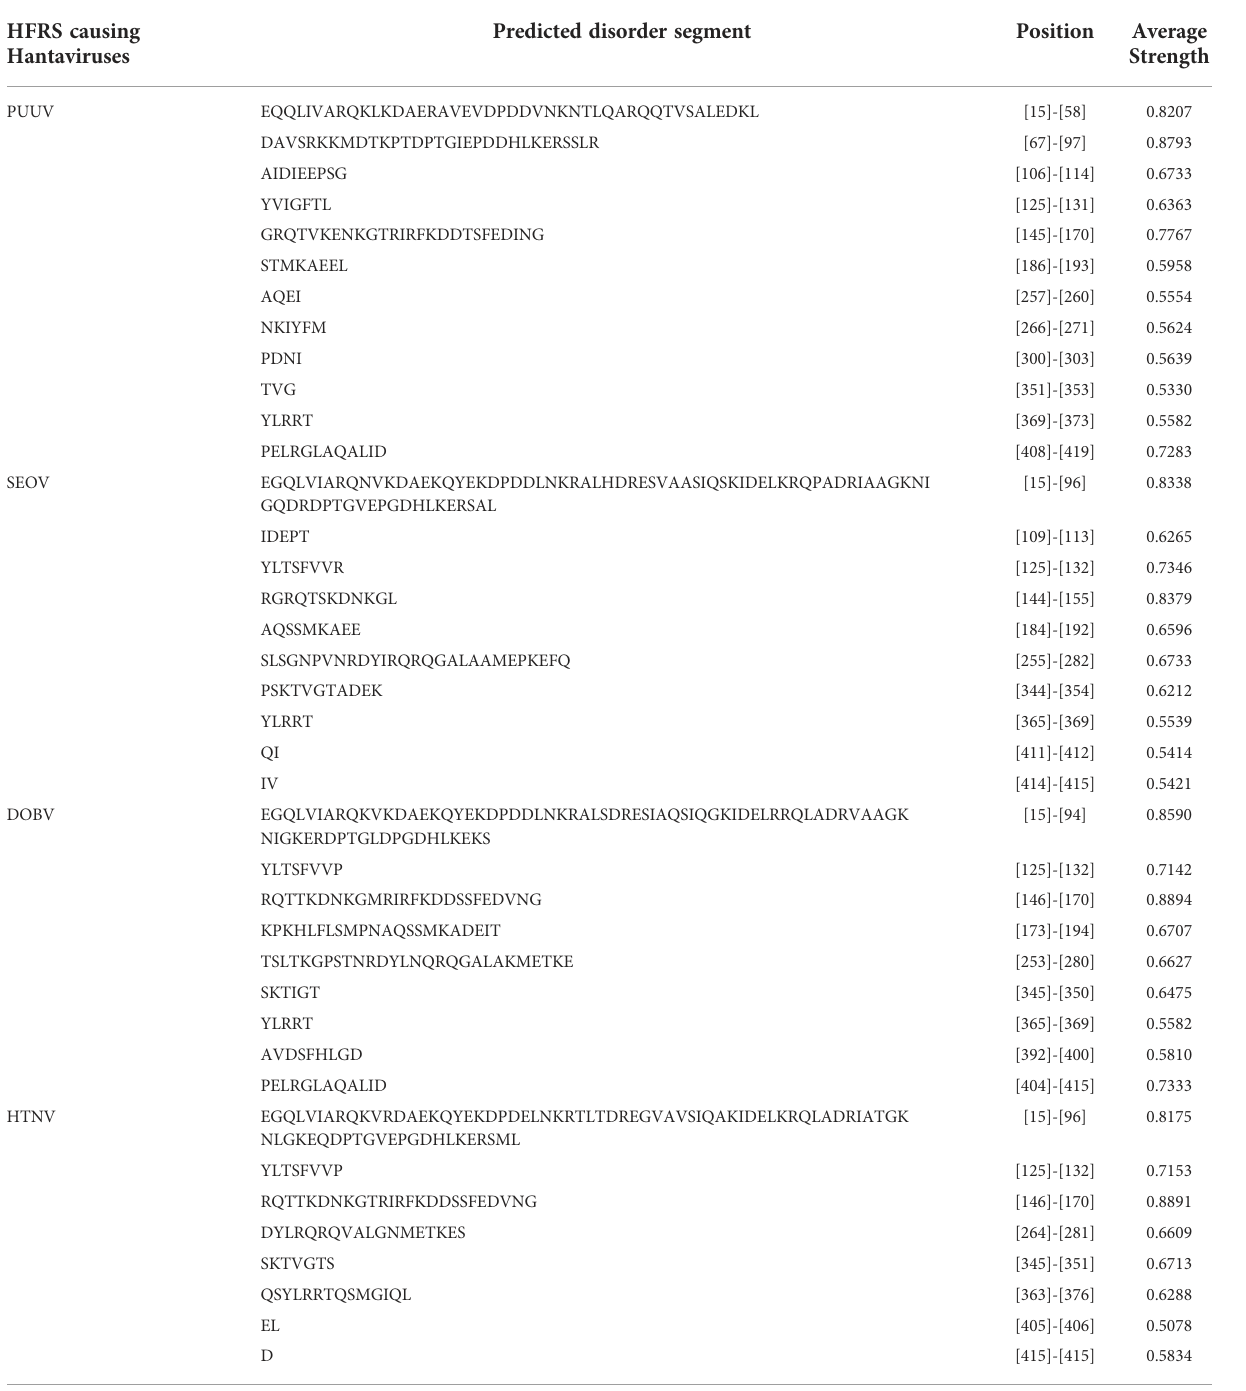
TABLE 2 Enlists internal disordered regions of PUUV, SEOV, DOBV, and